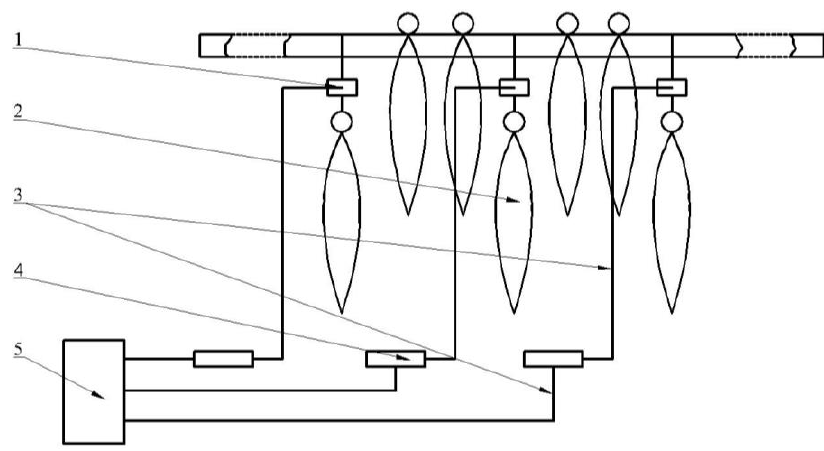
Figure 4. Schematic diagram of a gravity-measuring device. 1. Gravity sensors; 2. Tobacco leaves; 3. Signal lines; 4. Transmitters; 5. Paperless recorder.